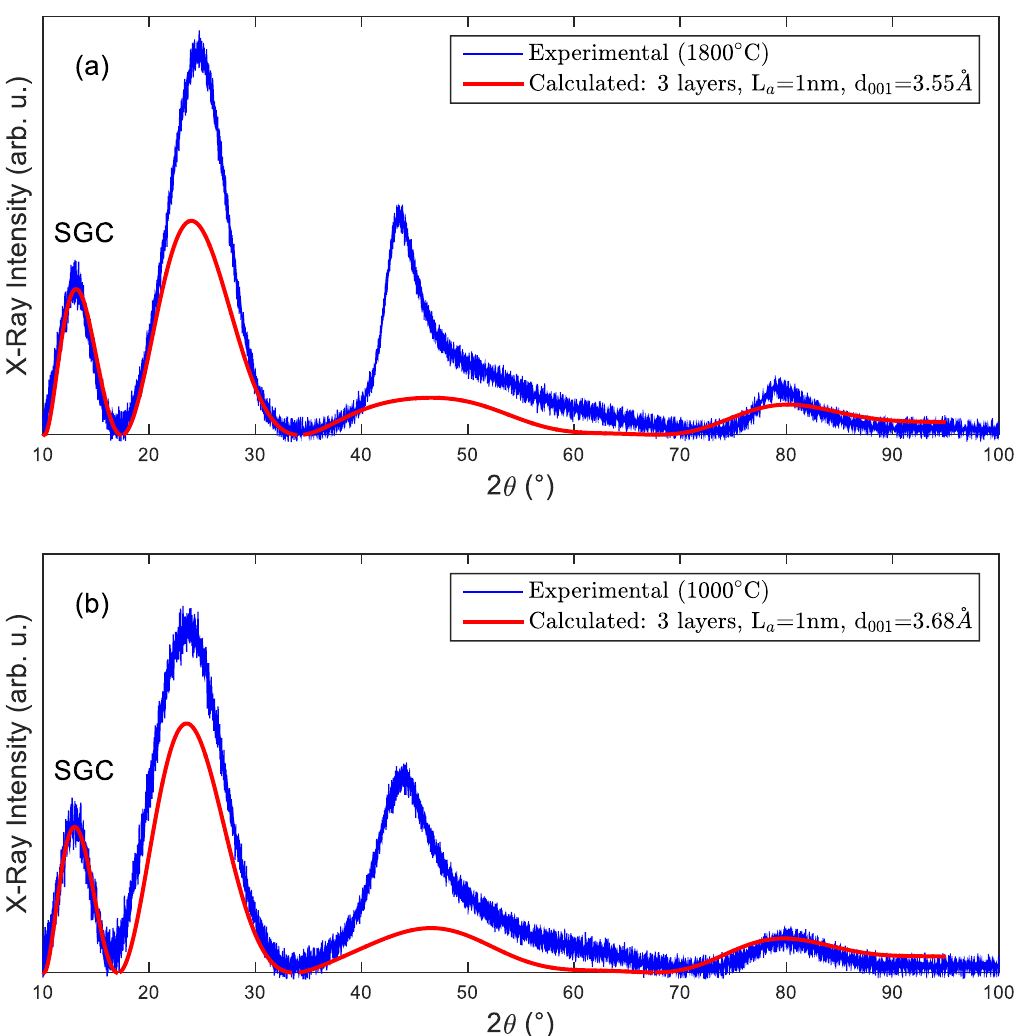
Figure 4. Calculated X-ray diffraction patterns after background removal (red lines) and experimental patterns after background removal normalised to the small graphene crystallite (SGC) peak (blue, noisy lines). The position of the SGC peak is dependent on L a . ( a , b ) correspond to the samples annealed at 1800 and 1000 °C, respectively.